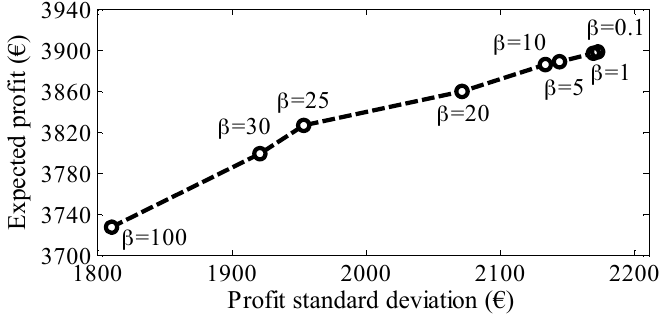
Figure 8. Variation of expected profit and conditional value at risk with varying β .